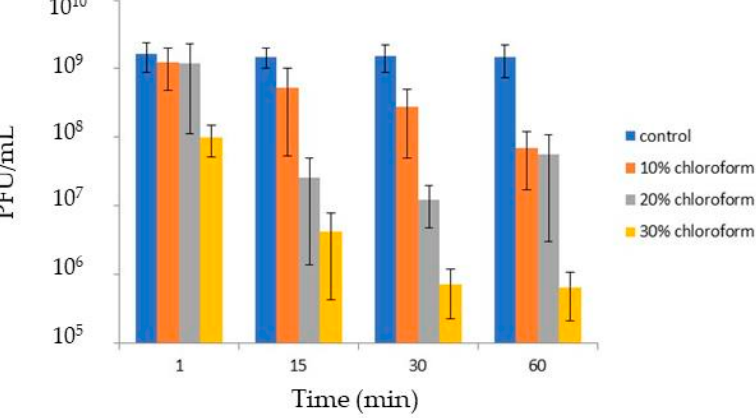
Figure 4. Sensitivity of GC1 to chloroform. The phage lysate was added with chloroform (10, 20 or 30%). After incubation for 1, 15, 30 or 60 min at room temperature, PFU were enumerated.